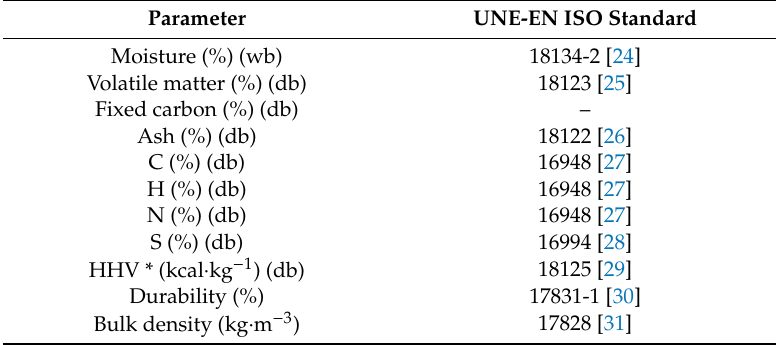
Table 1. UNE-EN ISO Standard.